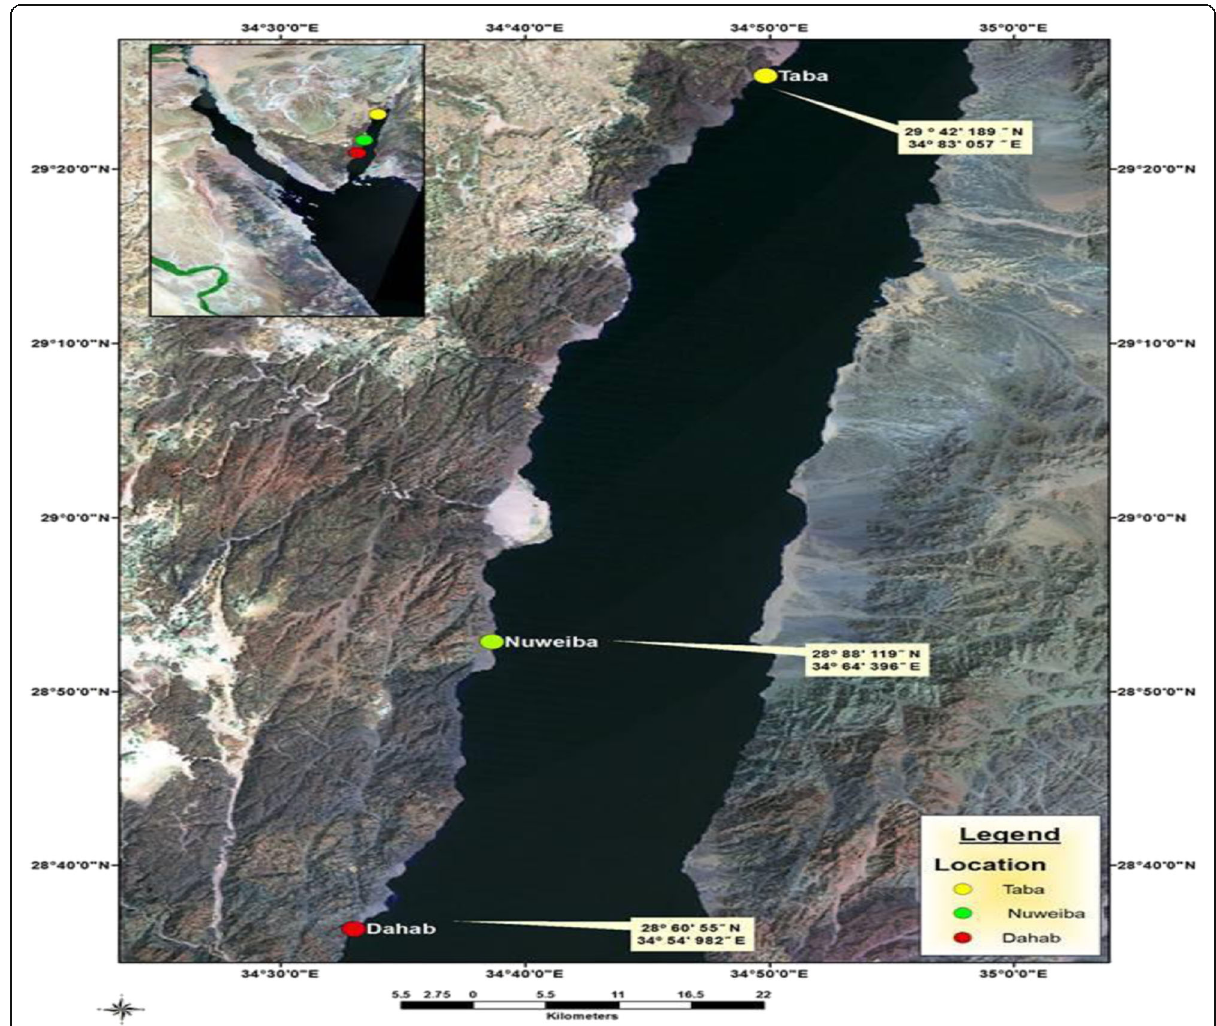
Fig. 1 Map showing the study sites along Gulf of Aqaba, Red Sea,